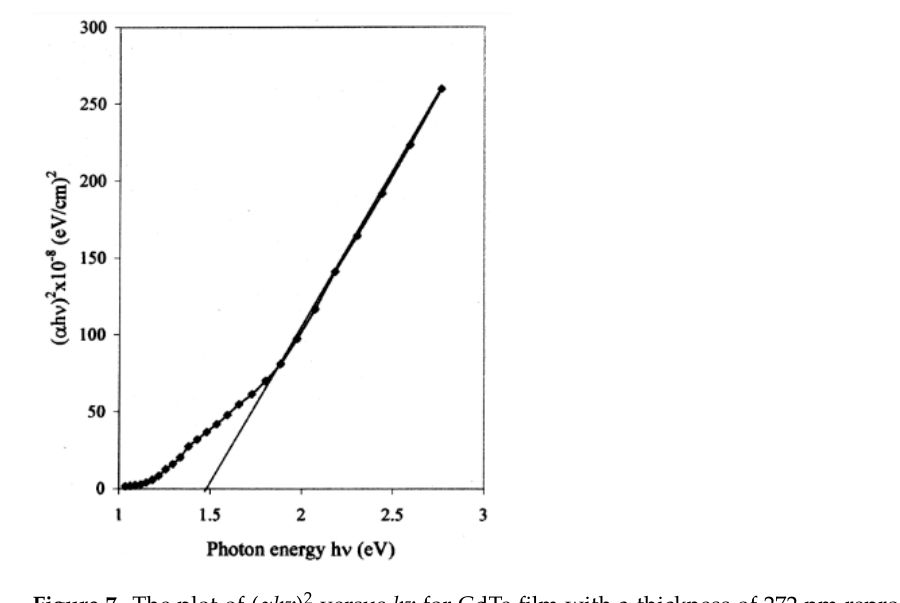
Figure 7. The plot of ( α hv ) 2 versus hv for CdTe film with a thickness of 272 nm reproduced with permission from [123], Springer, 2006.